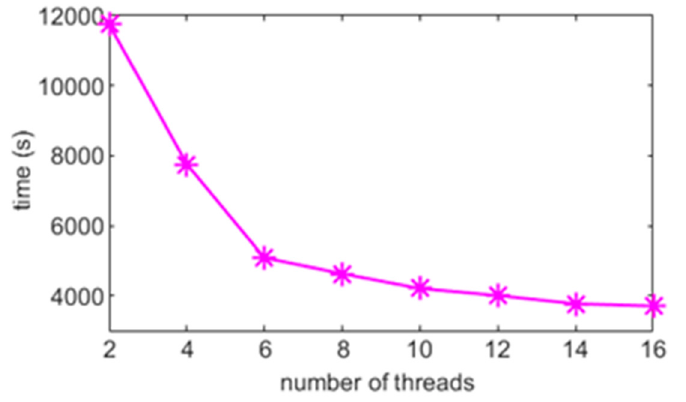
Figure 4. Computational time for different number of threads.